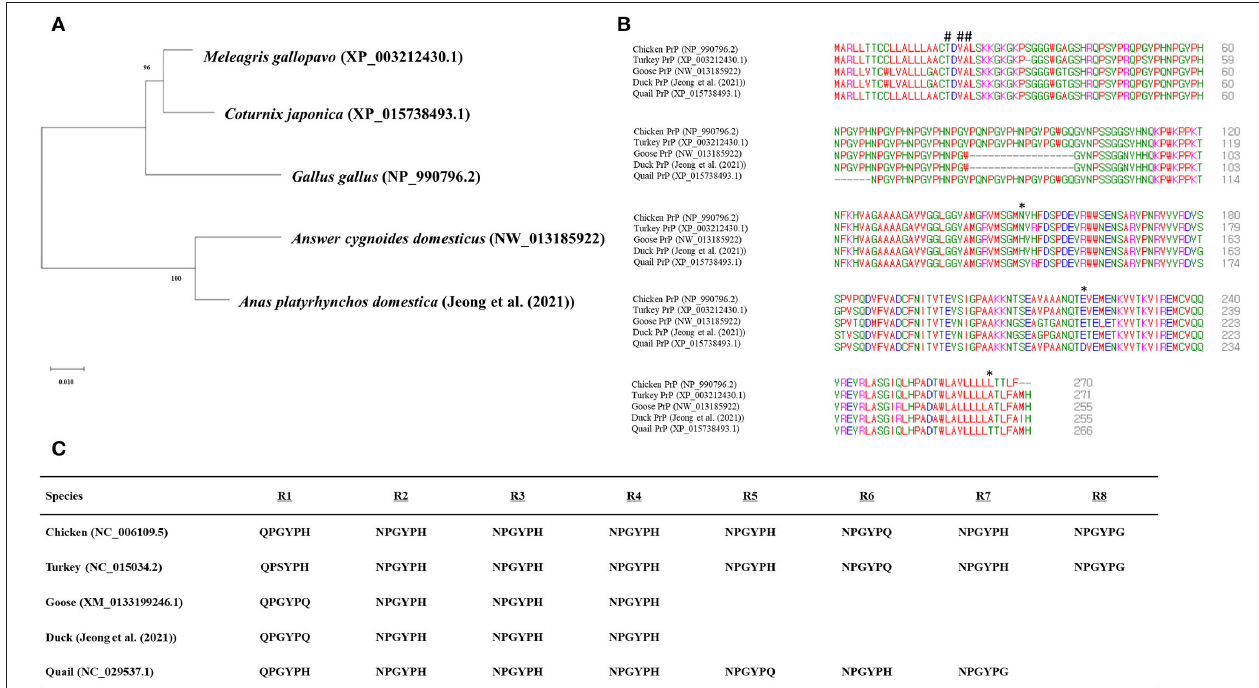
FIGURE 3 | Comparison of the amino acid sequences among five avian PrPs. (A) Phylogenetic analysis of the PrPs in the five avian species. (B) Multiple sequence alignment of the amino acid sequences of the five avian PrPs. Colors indicate the chemical properties of amino acids, namely, blue: acidic; red: small and hydrophobic magenta: basic; and green: hydroxyl, sulfhydryl, amine, and glycine. Asterisks indicate quail-specific amino acids. Sharps indicate T19I, V21I, and A22S. (C) Comparison of tandem repeat sequences in the five avian species. R1 - R8 indicate hexapeptide repeat regions of avian